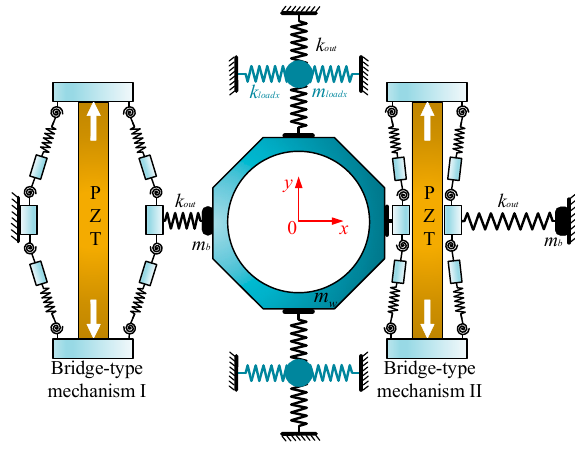
Figure 8. Mechanics model of the compliant platform in the X direction.